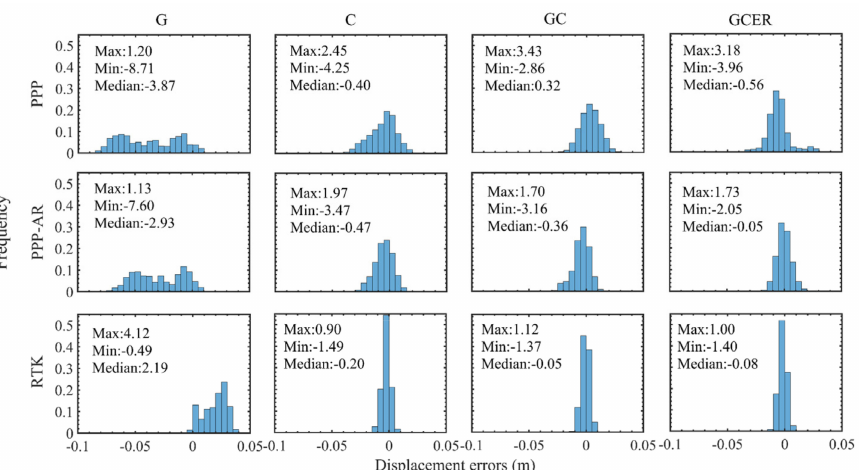
Figure 9. Histograms of displacement errors. From top to bottom, results correspond to PPP, PPP-AR, and RTK techniques while from left to right, results correspond to G, C, GC, and GCER observations, respectively. The maximum, minimum, and median values of each time series are given in each plot (in cm).